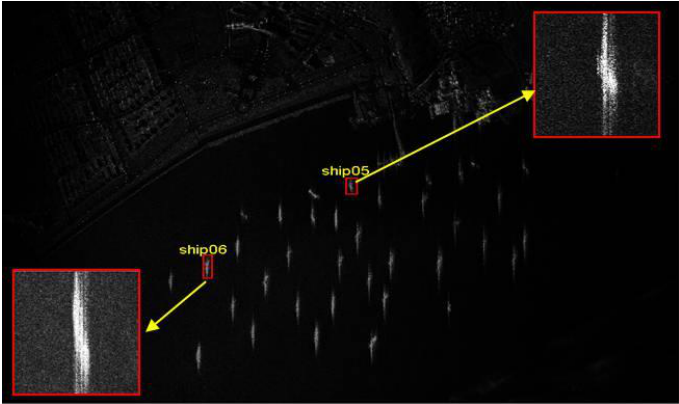
Figure 15. Two defocused ships are detected in airborne SAR images. Sub-images of ship05 and ship06 are located in airborne SAR image. The red rectangles are the zoomed sub-images.